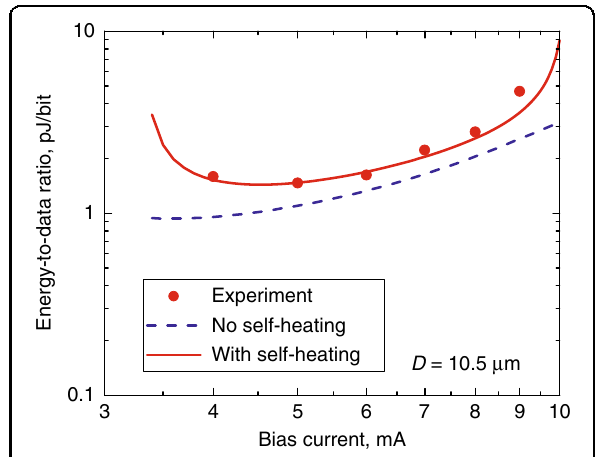
Fig. 17 Quantum dot microlasers on silicon. Reported threshold current density of QD-on-Si